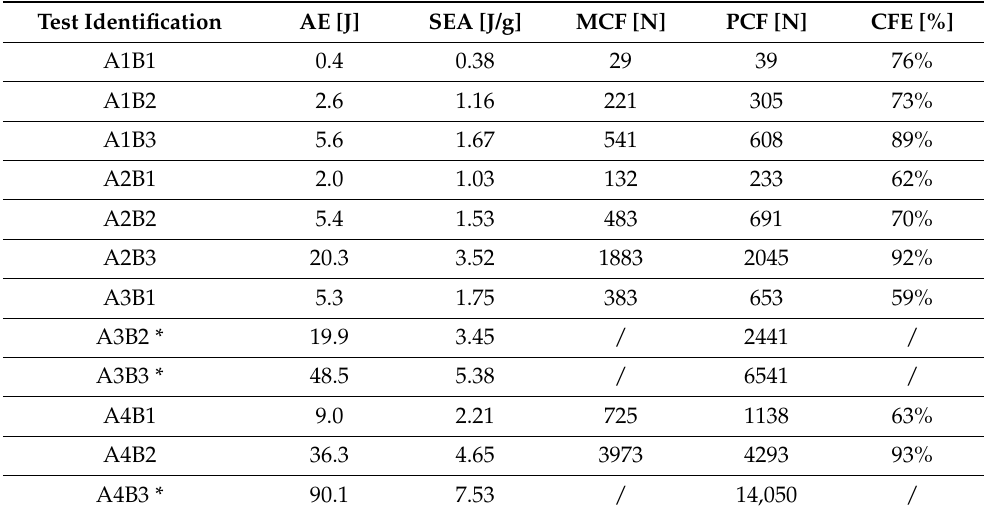
Table 3. Results of FP1 : Comparison of the absorbing capabilities of the investigated cells. Test